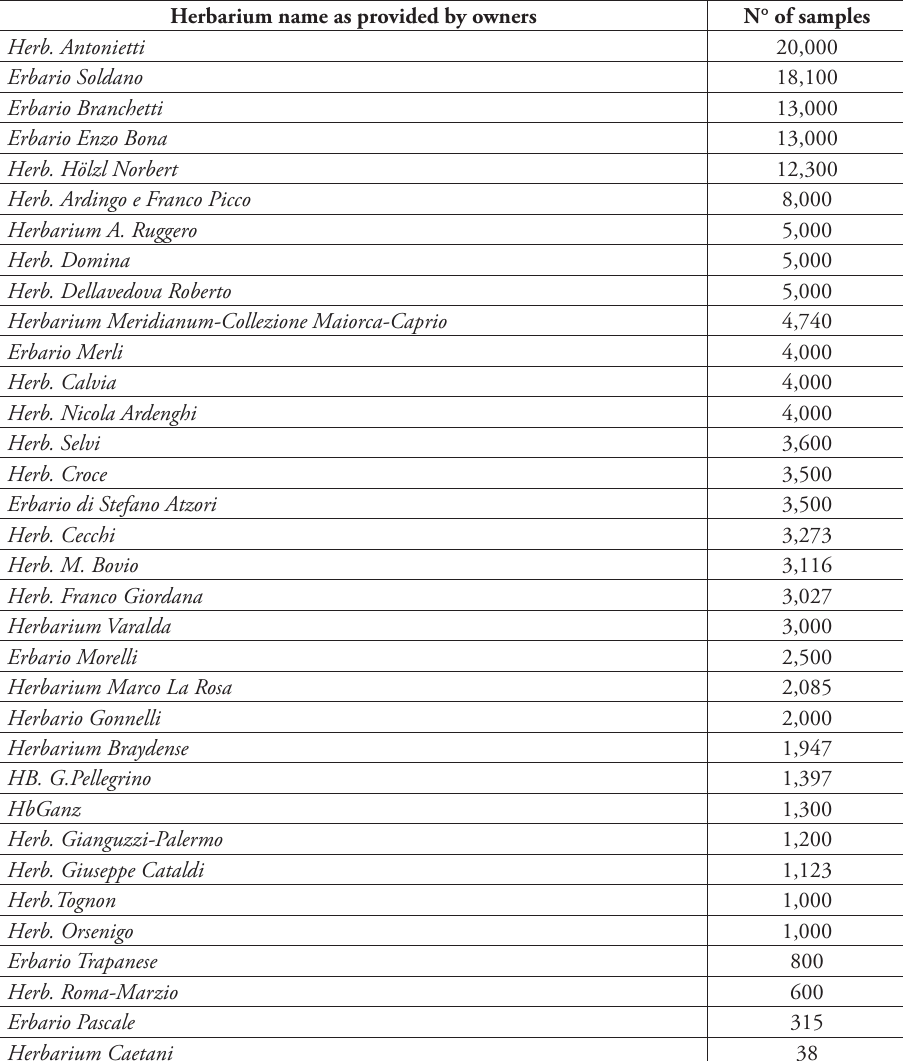
Table 2. Names and number of specimens preserved in the 34 Italian private herbaria resulted by present